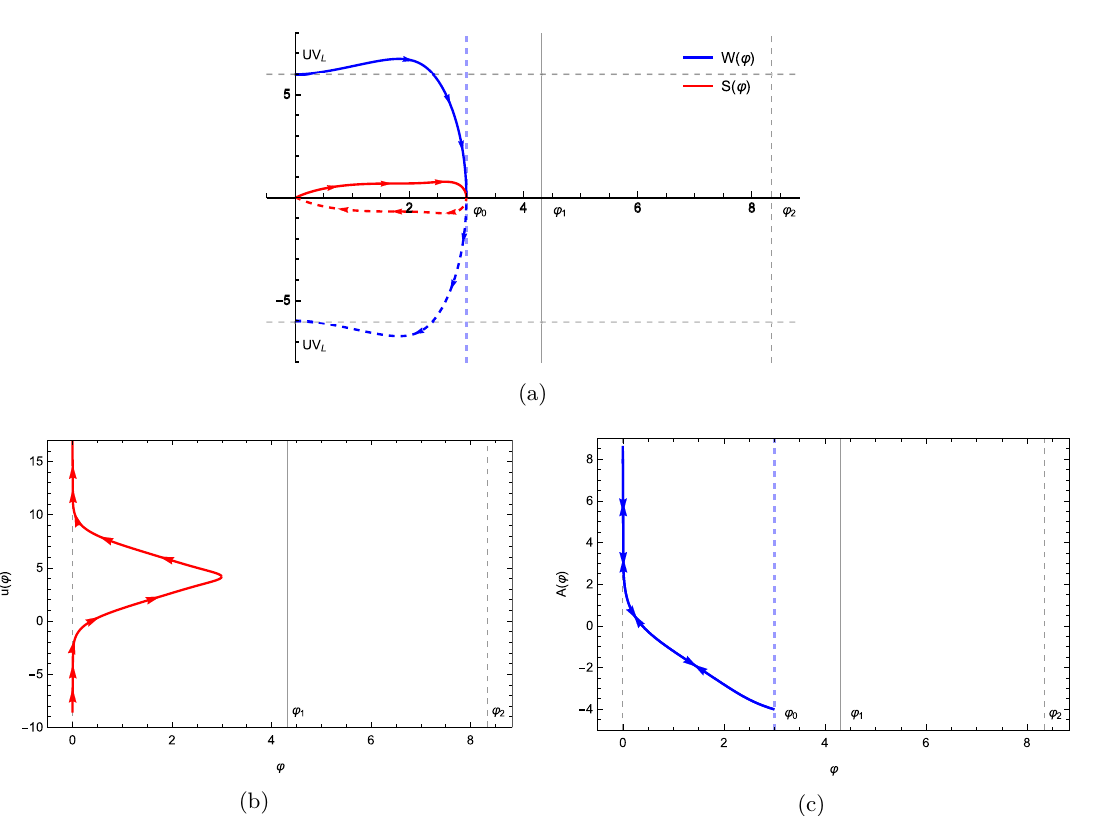
Figure 22 . Type S solution. (a): the blue and red curves describe W, S of the flow that starts from the UV boundary and reaches a special “IR-bounce” (at ϕ = ϕ , the blue dashed line): this is an L 0 A-bounce of the scale factor as well as a ϕ -bounce for ϕ at the same place. The flow returns to the same UV fixed point through the mirror image of the original flow (b): the holographic coordinate at the UV fixed point, tends to −∞ and at the IR-bounce it reaches a finite value. After that, it L tends to + ∞ and returns to the UV fixed point again. (c): the scale factor has an A-bounce at L ϕ 0 = 3 . 0 (at the blue dashed line) and is symmetric on the two sides of the